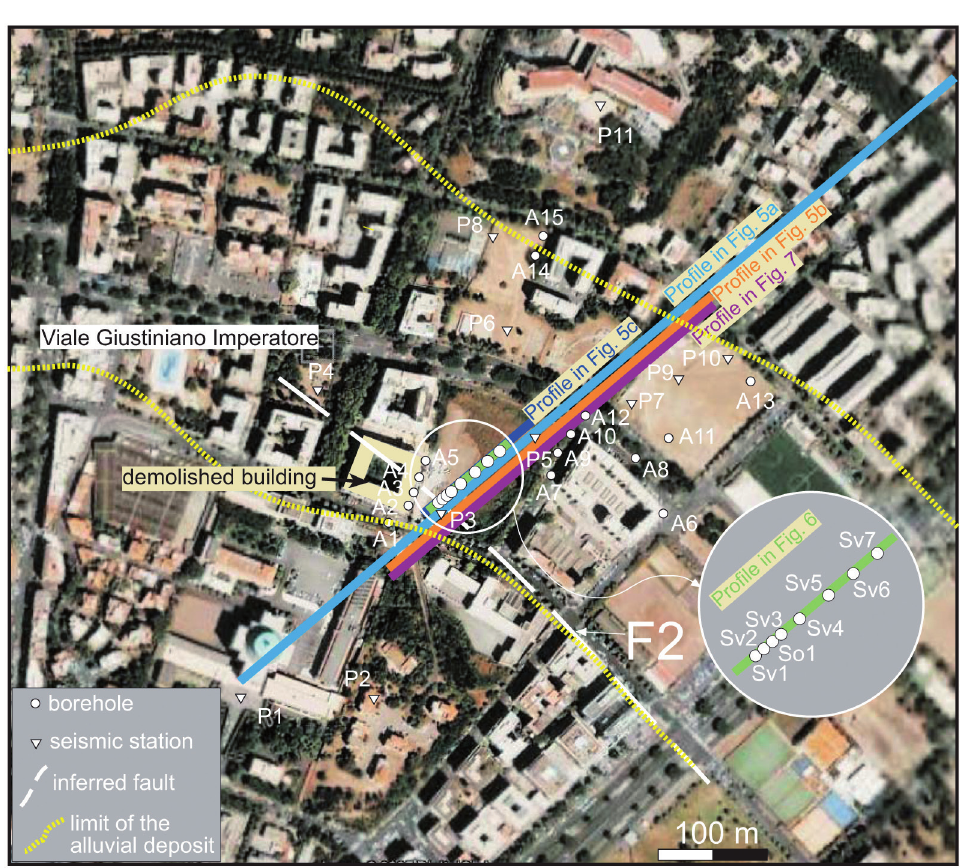
Fig. 3. Location of the geoelectric profile (blue line) and of the boreholes campaign performed in this study (Sv1-Sv7, So1, see the enlargement in the circle). The setting of the INGV seismic stations (P1-P11) at the Grot- taperfetta valley and the location of boreholes whose logs were acquired from different sources (A1-A15) are also